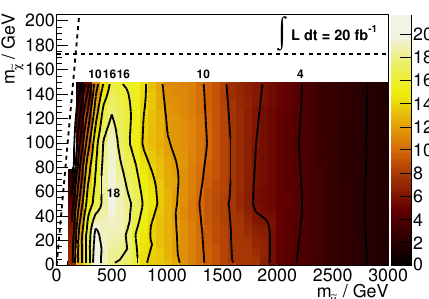
Figure 4. The m T ( (cid:22); =p ) threshold (GeV) used to de(cid:12)ne the signal region for each of the (cid:21) 0 T signal model considered, set for each model so as to maximise the median sensitivity.